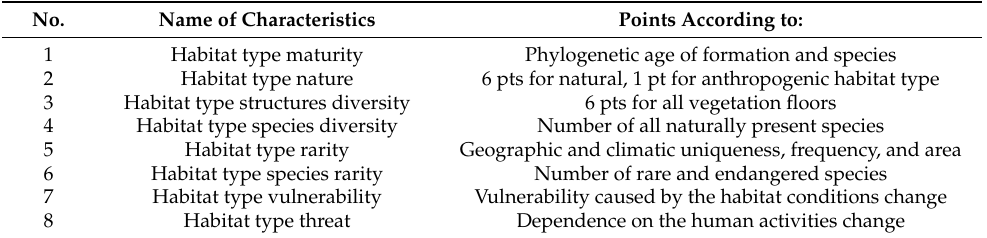
Table 2. Basic habitat ecological characteristics used within Habitat Valuation Method (HVM). No. Name of Characteristics Points According